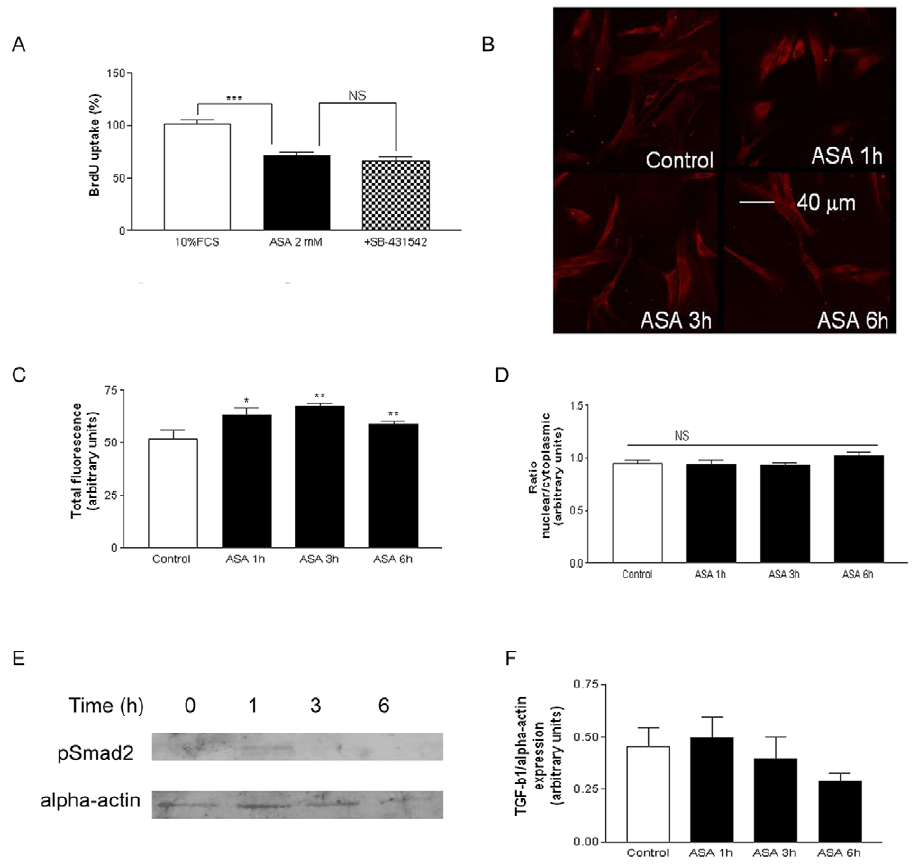
Figure 3. ALK-Smad pathways do not mediate the antiproliferative effect of ASA. Panel A: The ALK-5 blocker SB-431542 (10 m M) did not affect the antiproliferative effect of ASA (2 mM). Panel B: Representative images from cells treated with ASA (2 mM). Panel C: Quantitative analysis of whole-cell intensity of fluorescence in treated versus untreated samples. Panel D: Quantitative analysis of nuclear/cytoplasmic intensity in both groups. Panel E: representative Western blots of PSmad2 expression after incubation with ASA (2 mM). Panel F: Quantification of Western blot experiments of PSmad2 after incubation with ASA (2 mM). Bar graphs show the mean 6 S.E.M of n=4 experiments (cell cultures from 4 different patients). * P , 0.01, ** P , 0.01, *** P , 0.001.